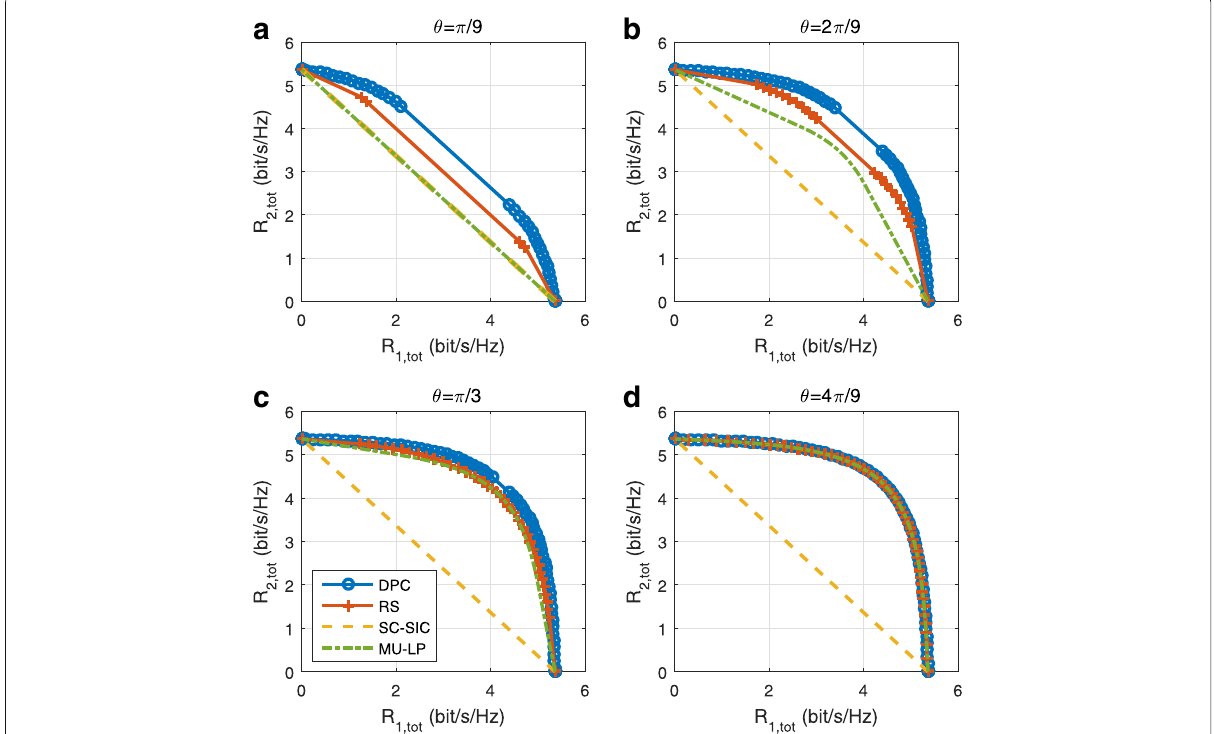
Fig.22 Achievablerateregioncomparisonofdifferentstrategiesinunderloadedtwo-userdeploymentwithperfectCSIT, γ = 1, N t = 4,SNR=10dB. a θ = π/ 9. b θ = 2 π/ 9. c θ = π/ 3. d θ = 4 π/